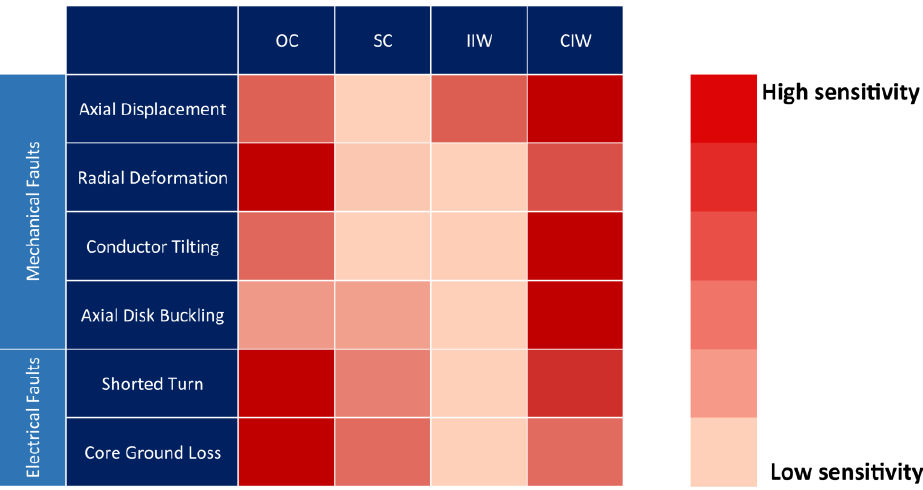
Figure 28. Identification of the most sensitive connection scheme for various electrical and mechanical faults; patterns are based on the minimum value of SDD (MSDD).